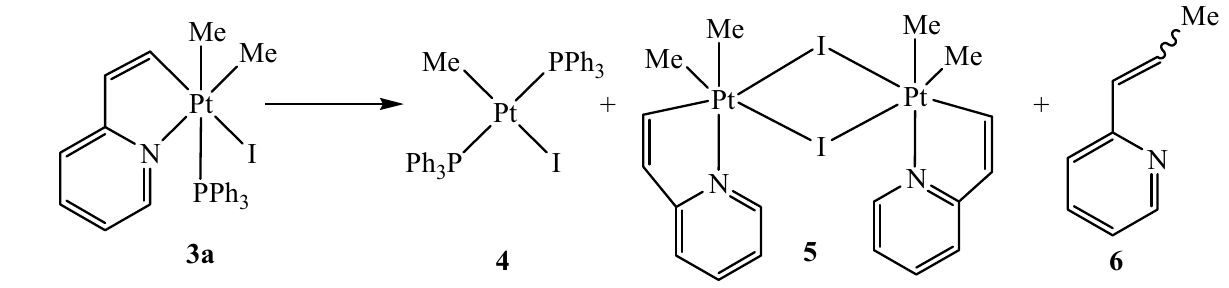
Scheme 2. Decomposition pathway of 3a (similar to that observed for 3b ) [76].